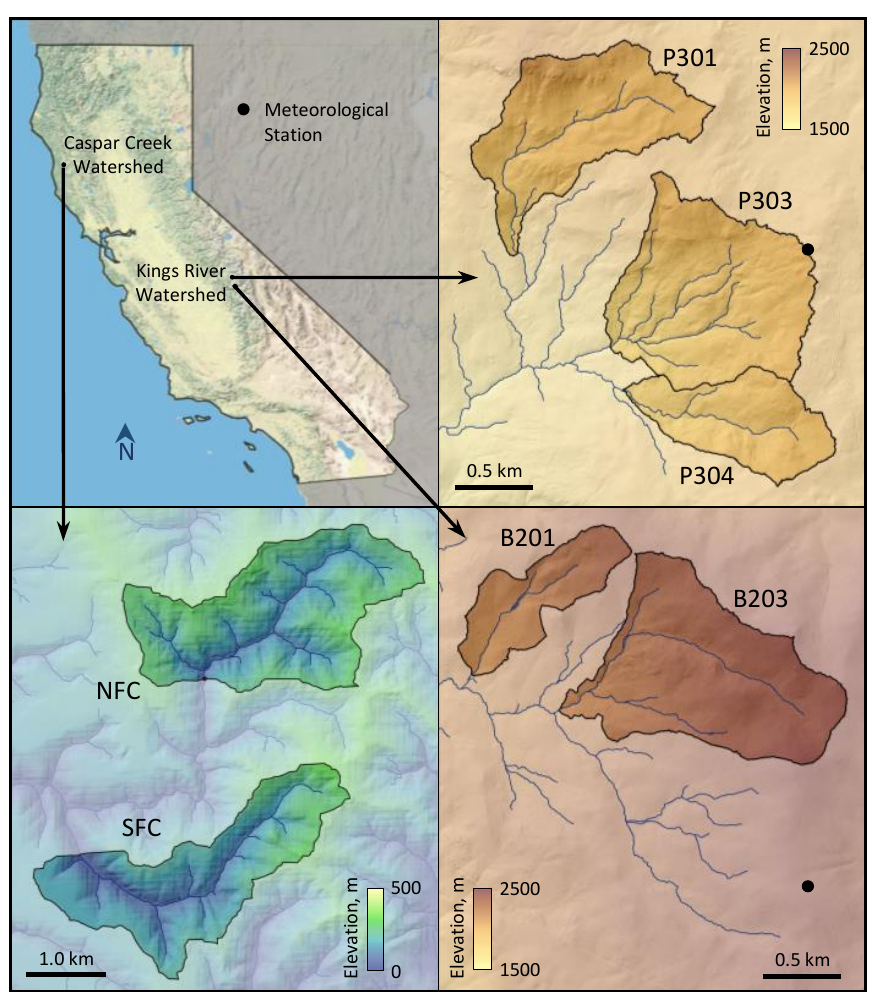
Figure 1. Research watershed locations, including Caspar Creek (NFC, SFC), Providence Creek (P301, P303, P304), and Bull Creek (B201, B203). The McGuires meteorological station used for Caspar Creek is located off the inset map, 8.5 ‐ km to the east of the NFC sub ‐ watershed. Table 1. Study site characteristics of elevation, mean annual precipitation (Mean P), mean annual temperature (Mean T), and annual temperature range (Min ‐ Max T).